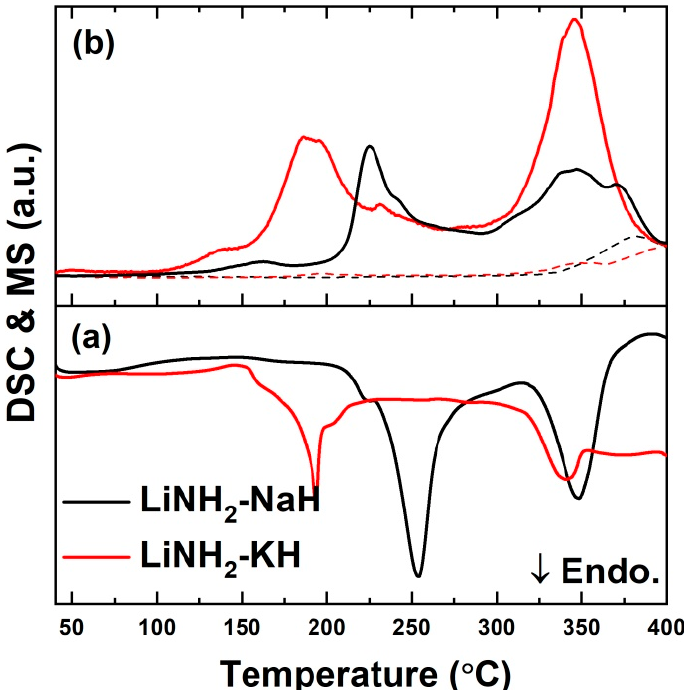
Figure 1. ( a ) DSC profile of LiNH 2 -KH and LiNH 2 -NaH system ( b ) Thermal desorption mass spectroscopy of LiNH 2 -KH and LiNH 2 -NaH system (H 2 spectrum is shown by solid line and NH 3 spectrum is shown by dashed line).